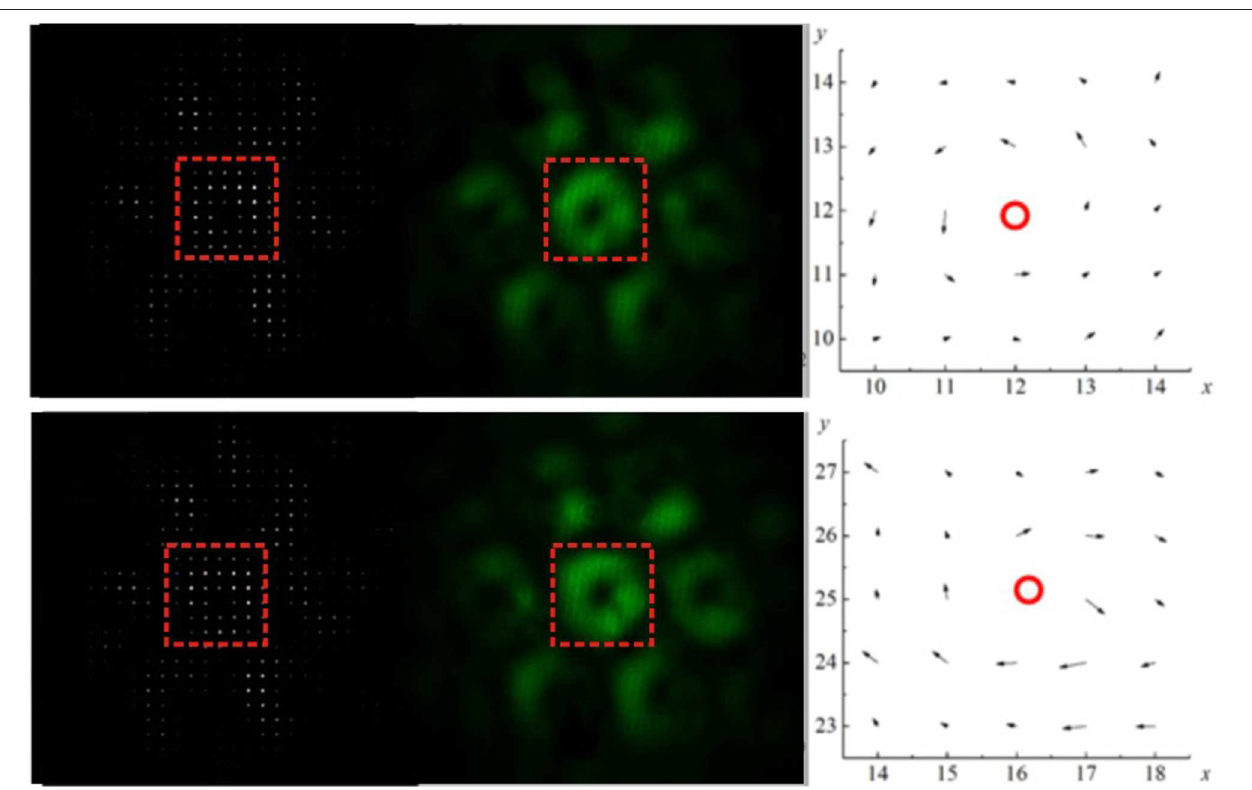
FIGURE 9 | Calculated radiation intensity distribution at the photodetector array of the Shack–Hartmann sensor (left), measured radiation intensity distribution (center), and measured local wavefront tilts (right) of the synthesized vortex beam. Local wavefront tilts correspond to the zone shown by the red rectangle. Numbers of lenslets (lenslet array) of the Shack–Hartmann sensor are plotted at the axes. Red circle show the zone of the vortex center. The top line is for the optical vortex with l 1, and the bottom line is for the optical vortex with l 1 + = −